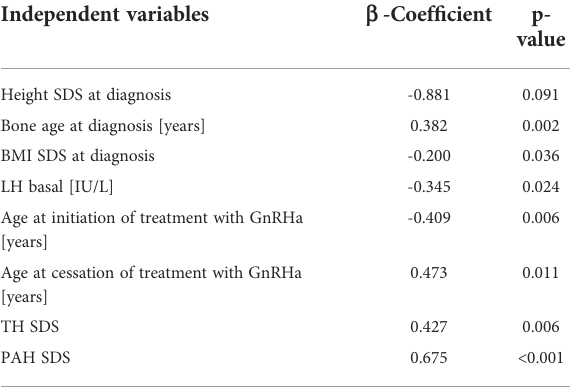
TABLE 6 Multivariable analysis of variables signi fi cantly associated with fi nal height SDS of 48 girls with iCPP treated with GnRHa.